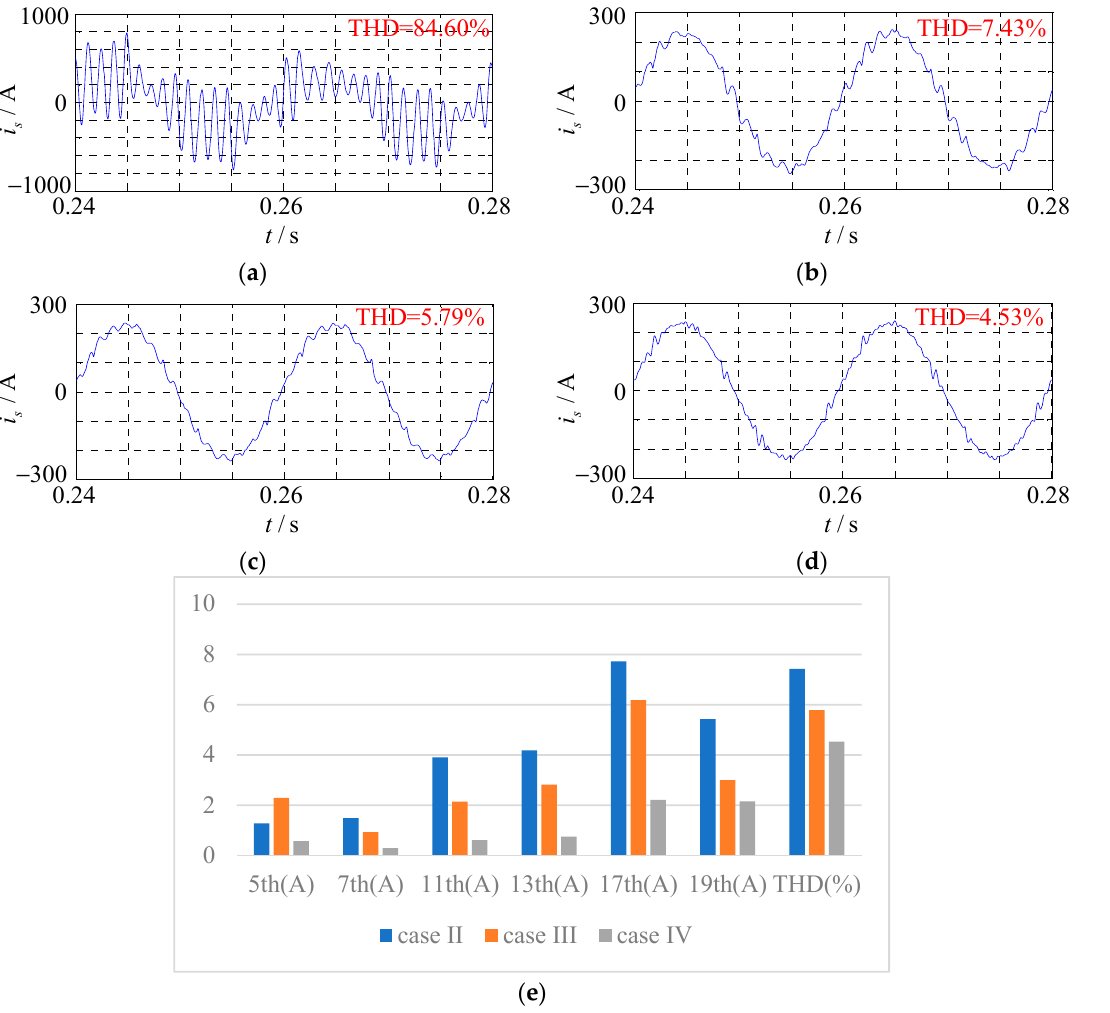
Figure 18. The filtered grid current performance in different cases with a capacitive load: ( a ) case I, full harmonic compensation; ( b ) case II, selective harmonic compensation; ( c ) case III, combining selective harmonic compensation and resonance damping strategies; ( d ) case IV, the proposed compound control; ( e ) comparison of grid current harmonic in three cases.